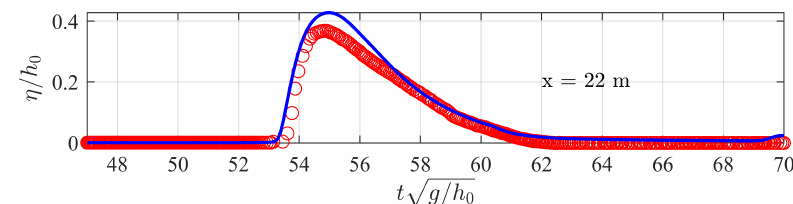
Figure 9. Time series of the surface elevation at edge of the reef. The blue line is the numerical model results the red circles are the measurements by [29].